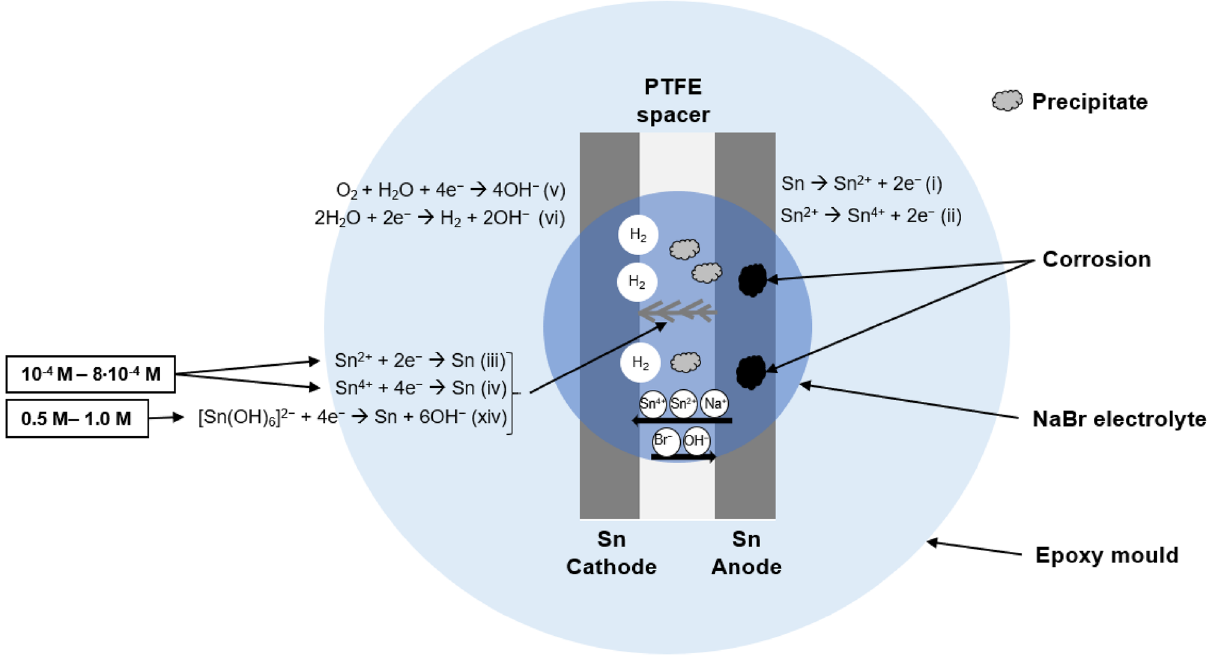
Figure 8. Schematic of plan view of electrochemical cell formed during WDT at applied bias of 3 V, in NaBr concentration of (not drawn to